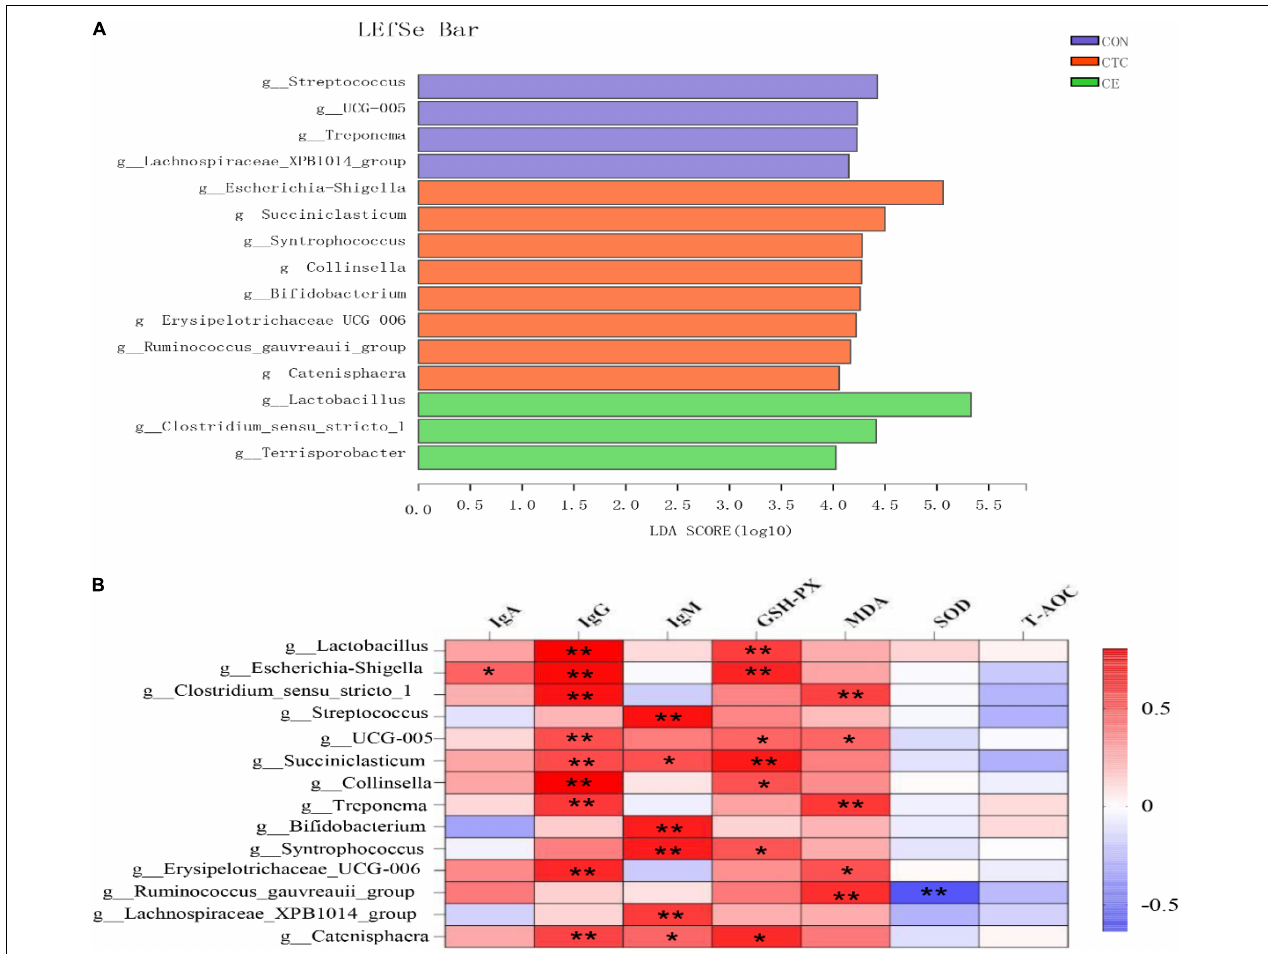
FIGURE 3 | Identification of the most differentially abundant genera in cecum (A) . The plot is generated from Linear Discriminant Analysis Effect Size (LEfSe) analysis with CSS-normalized OTU table and displays taxa with LDA scores above 4 and p -values below 0.05. Genera enriched in the samples with CTC diet are indicated with red bars, genera enriched in the samples with CON diet are indicated with blue bars, and genera enriched in the samples with CE diet are indicated with green bars. The individual minipig was regarded as the experimental unit ( n = 8). CE, compund enzyme group; CON, basal diet group; CTC, chlortetracycline group. Correlation analysis between serum biochemical parameters and cecal microorganisms (B) . * p < 0.05 and ** p < 0.01 represent significant difference,